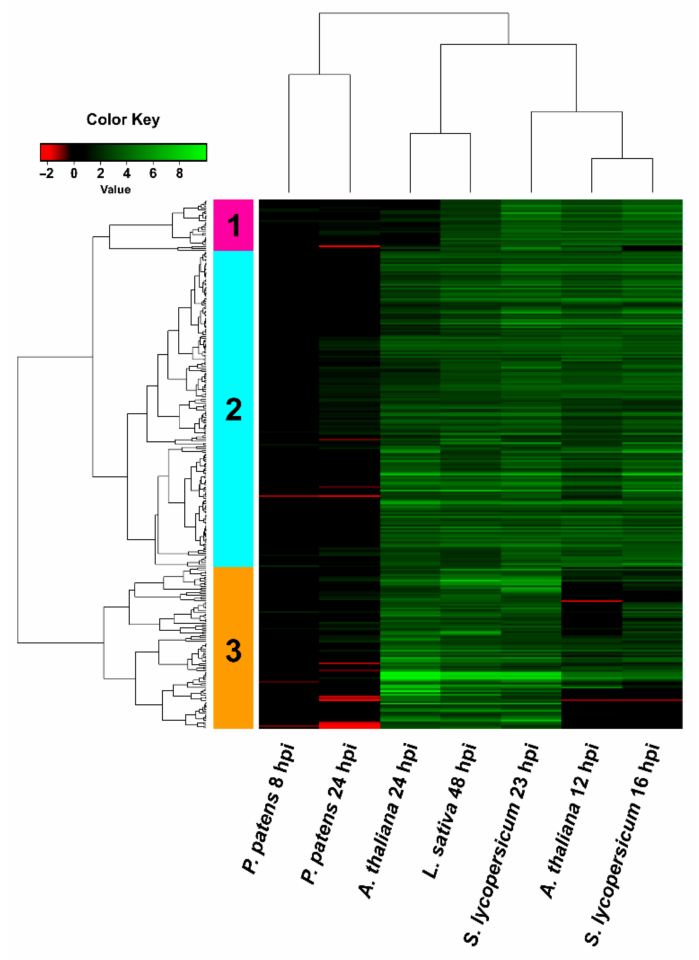
Figure 8. Hierarchical clustering (heat map) showing B. cinerea DEGs only upregulated in an- giosperms. DEGs correspond to the 288 genes that were upregulated in all angiosperms and not in P. patens . Selected DEGs had log2 FC ≥ 2, FDR ≤ 0.05, and were expressed differentially in at least one time point for each plant species. For samples where no significant difference with control was observed (FDR > 0.05) or no data was available, the log2 FC was assigned as cero. See Table S14 for complete